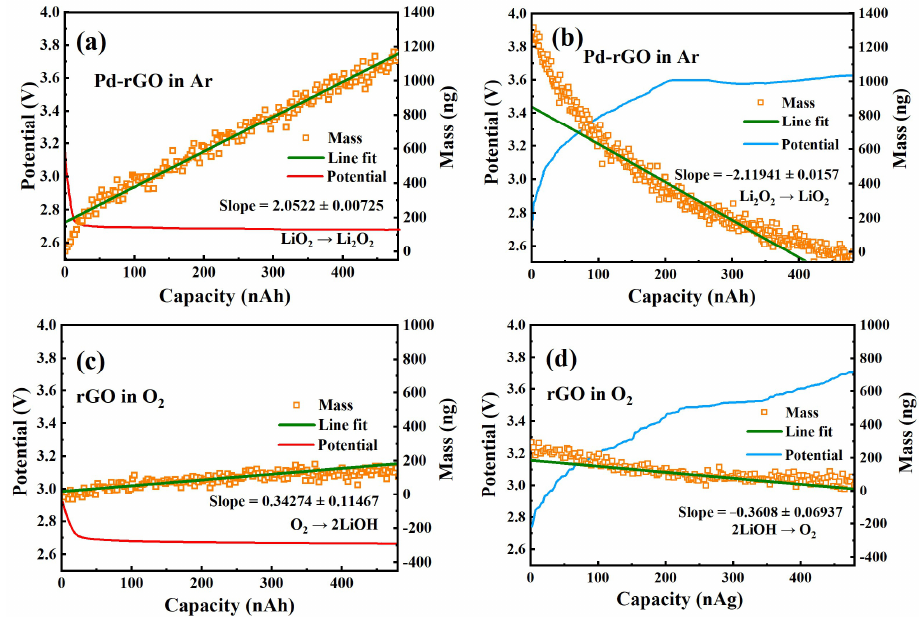
Figure 4. Mass change of Ti film quartz crystal in the LiTFSI/TEGDME electrolyte at a 1 μA. ( a , b ) Discharge and charge curves and mass changes of Li-O 2 battery with Pd–rGO as a catalyst in Ar (simulate closed battery status). ( c , d ) Discharge and charge curves and mass changes of Li–O 2 battery with rGO as a catalyst in O 2 (simulate open Li-O 2 battery status). Table 2. The EQCM experimental matrix of different products.